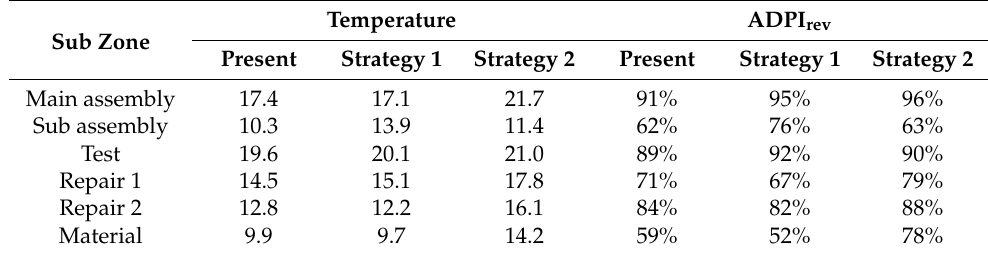
Table 7. Average temperature and ADPI at the sub